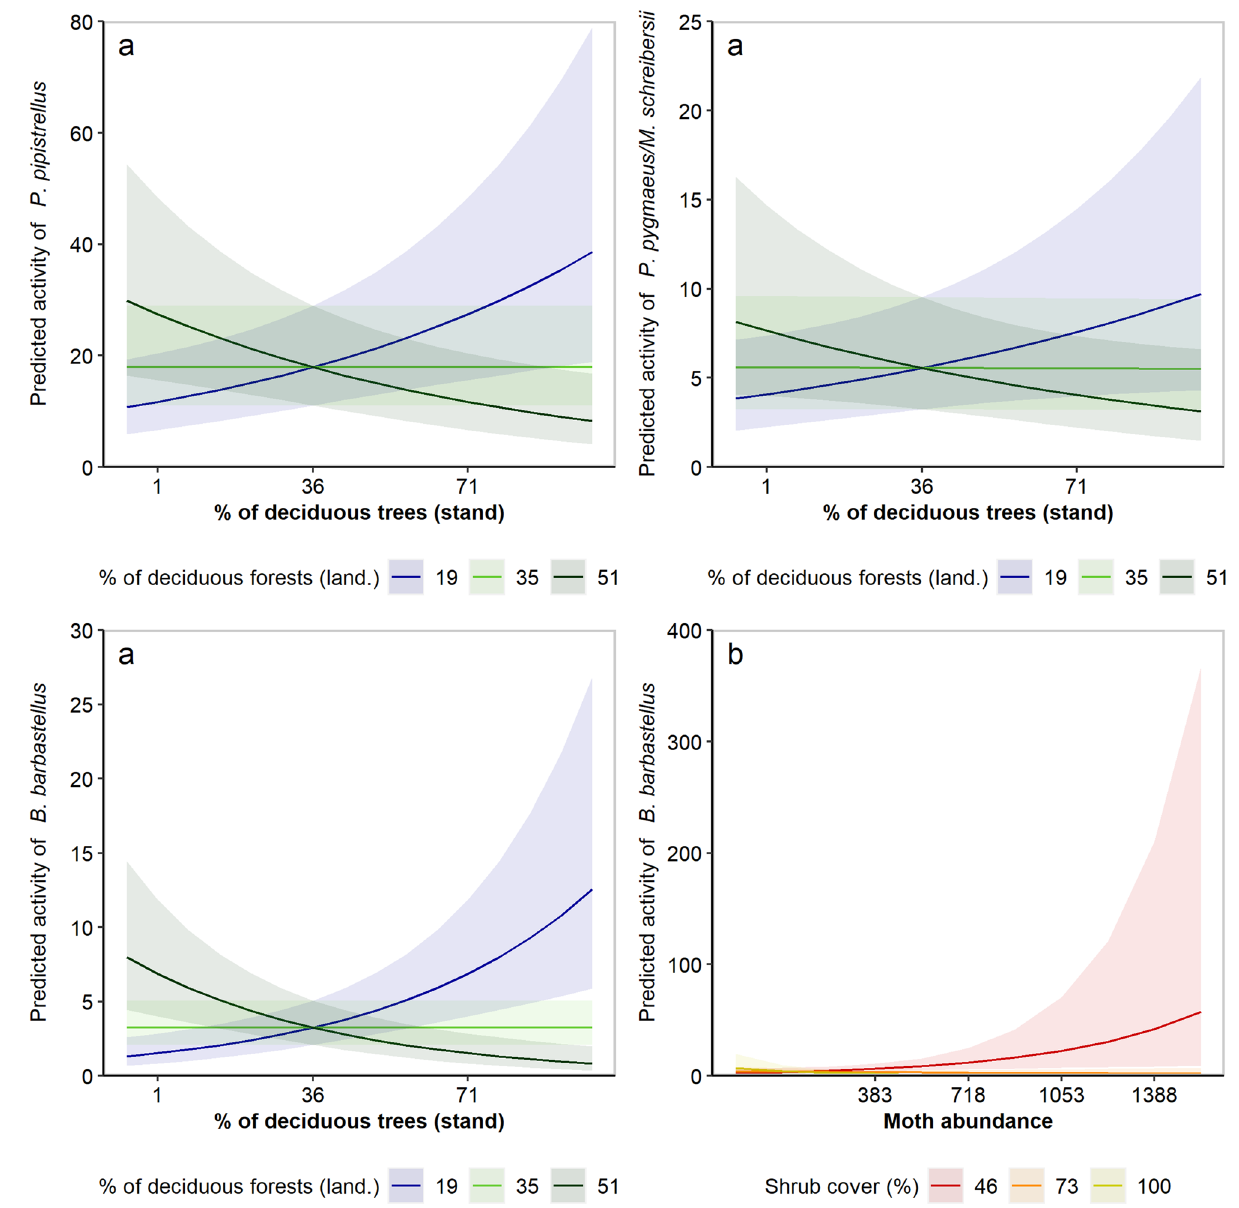
Figure 1. Predicted responses of ( a ) bats to stand composition at each level (mean, mean-SD, mean + SD) of landscape composition; and ( b ) B. barbastellus to moth abundance at each level (mean, mean-SD, mean + SD) of shrub cover. Stand composition corresponds to the percentage cover of deciduous trees within stand while landscape composition was inferred using the proportion of deciduous forests within the forested landscape area at 1 km radius scale. Predictions from GLMMs are represented by the solid lines with 95% confidence intervals indicated in the same